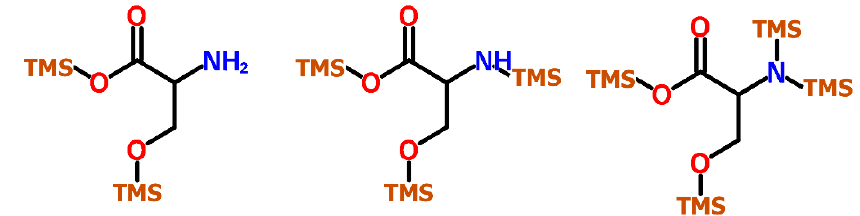
Figure 1. Trimethylsilylation levels of the amino acid serine commonly found in TMS derivatized samples. In serine (2TMS), the OH- and COOH-group are trimethylsilylated, in serine (3TMS) one OH-group of the amino group is exchanged, while in serine (4TMS) all active hydrogens are